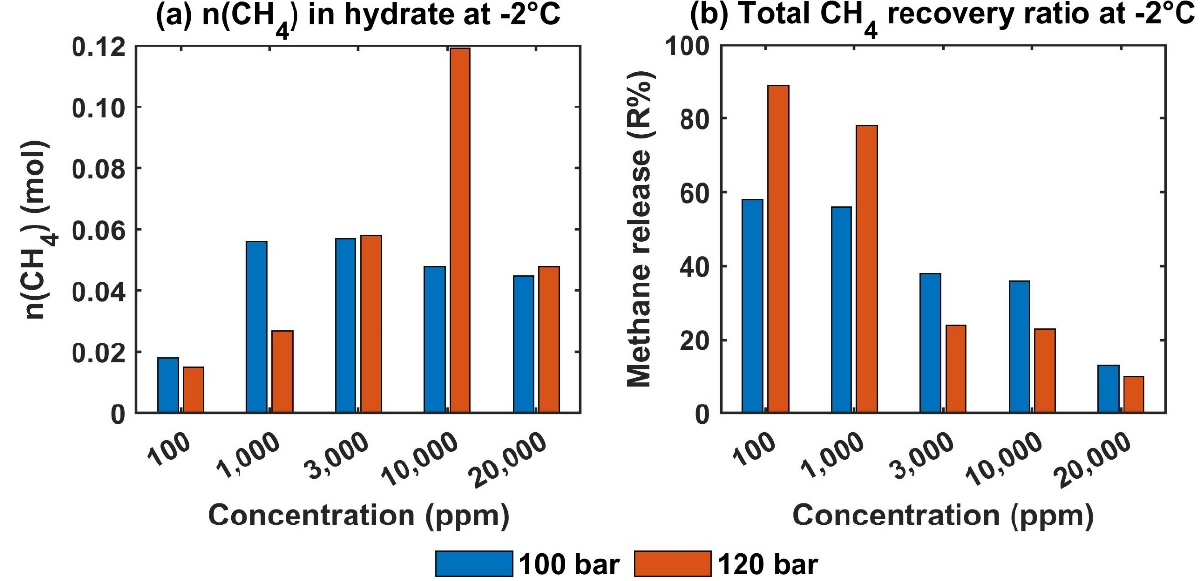
Figure 12. Effect of temperature decrease from 1 °C to − 2 °C on the CH 4 uptake in hydrate (in the presence of histidine) (refer ( a )) for two different starting pressures (100 and 120 bar). ( b ) shows CH 4 (R) number (for five different concentrations of histidine) at two different pressures (100 and 120 bar) at T = − 2 °C.